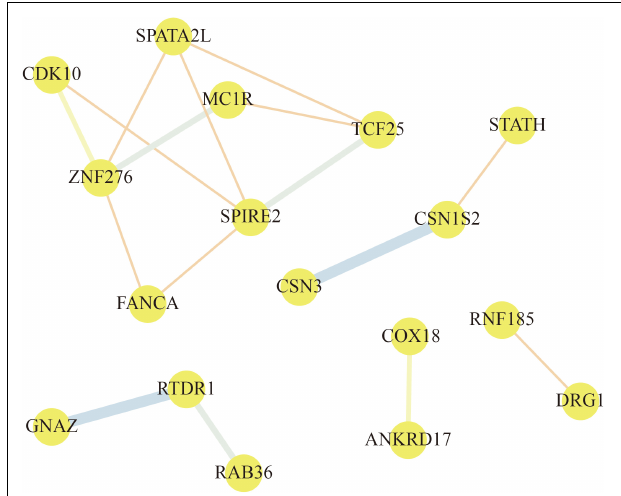
FIGURE 7 | Protein–protein interaction (PPI) network of selected gene. The nodes represent proteins, and the line between the nodes indicate interactions between two connecting differentially expressed proteins (DEPs). The thickness of the line indicates the degree of